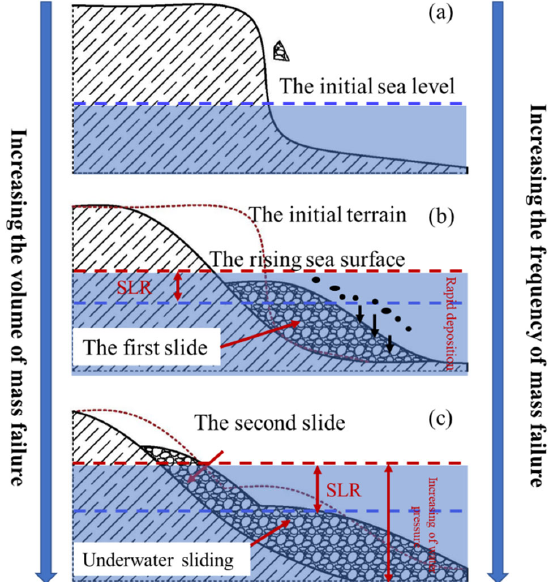
Figure 7. Coastal and submarine material instability model induced by sea ‐ level rise.